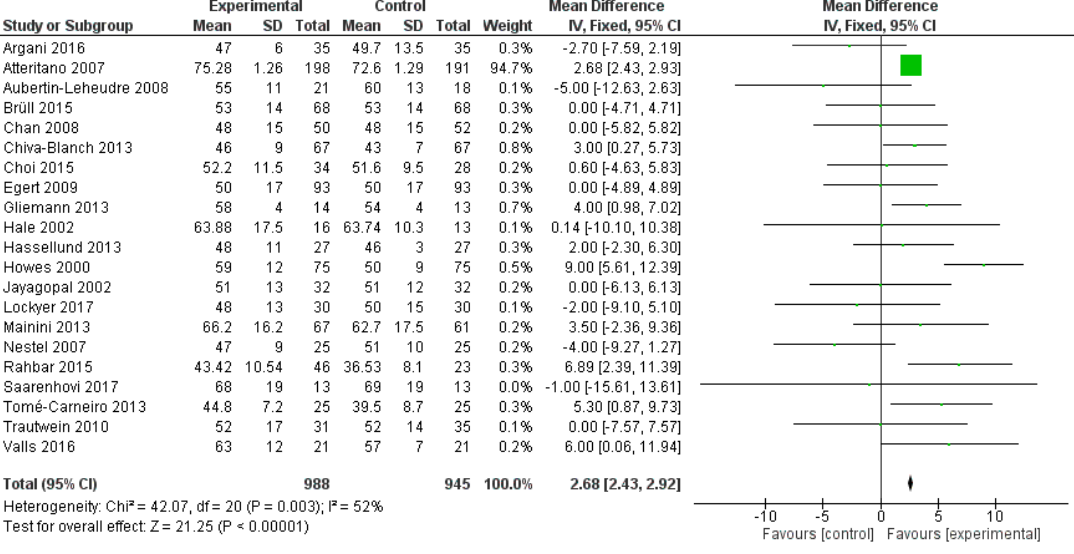
Figure 4. Pooled analysis of association between polyphenol intake and high-density lipoprotein cholesterol (HDL-C).